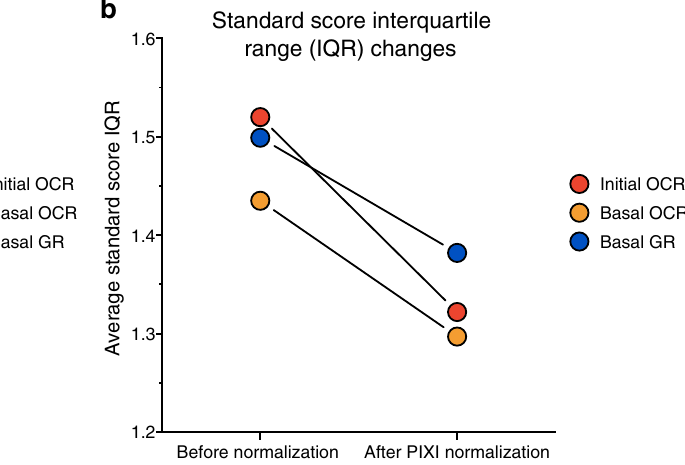
Figure 5. The effects of PIXI analysis normalization on the standard scores and standard score interquartile ranges (IQR). Mean standard scores and standard score interquartile ranges of all technical replicates within each cell density (50–300 × 10 3 cells/well, n = 14–16) were averaged and used to create an overall average standard score and standard score IQR for each XF assay parameter (N = 18) as a measure of accuracy (standard score) and precision (IQR). ( a , b ) Effects of brightfield image PIXI analysis normalization on the average